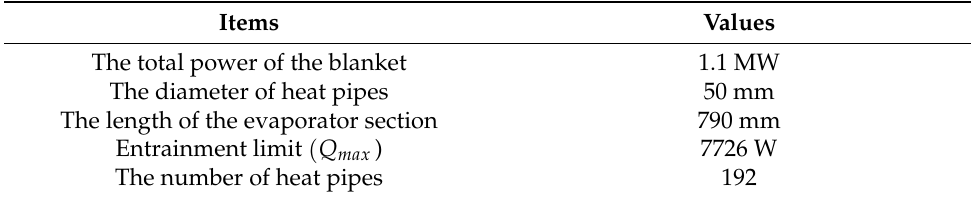
Table 2. The parameters of the heat pipe. Items